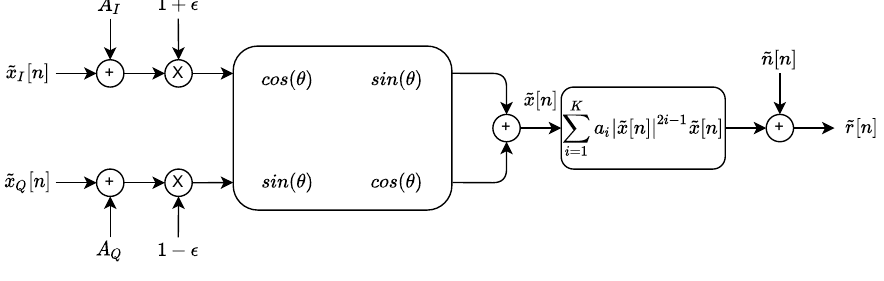
Figure 5. Impairments